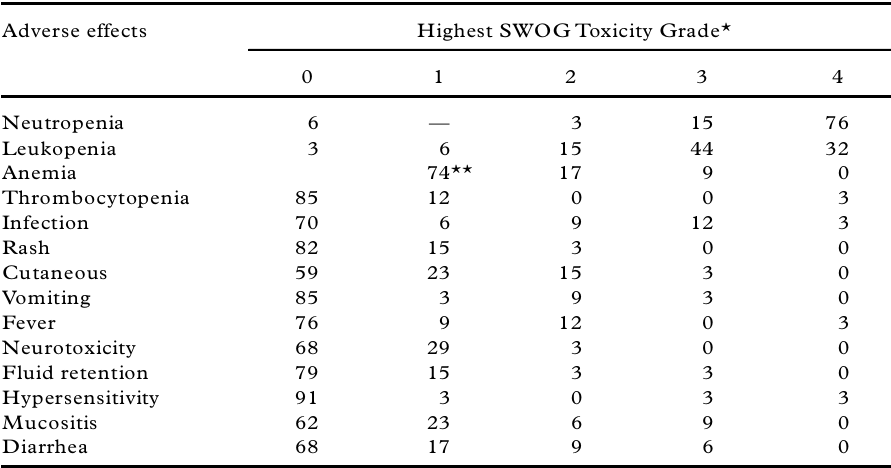
Figure 1. Progression-free (PF) and overall survival (OS) of patients with refractory soft tissue sarcoma after treatment with docetaxel. Table 3. Toxicity of